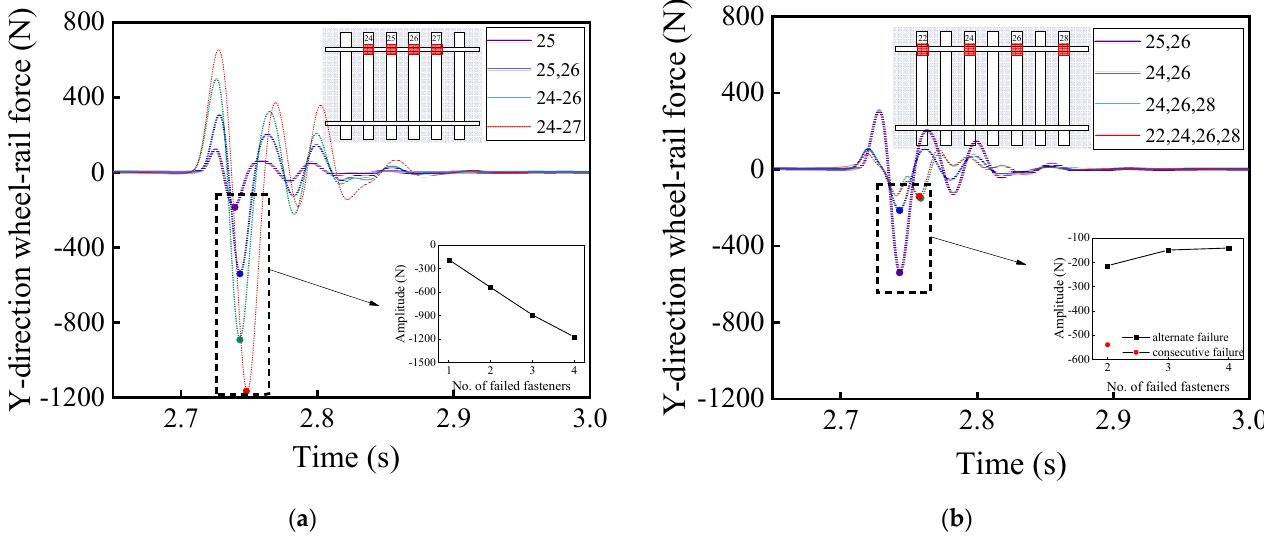
Figure 19. Model-calculated time-history variations of lateral wheel-rail contact force with ( a ) single-side consecutive and ( b ) single-side alternate fastener failures.